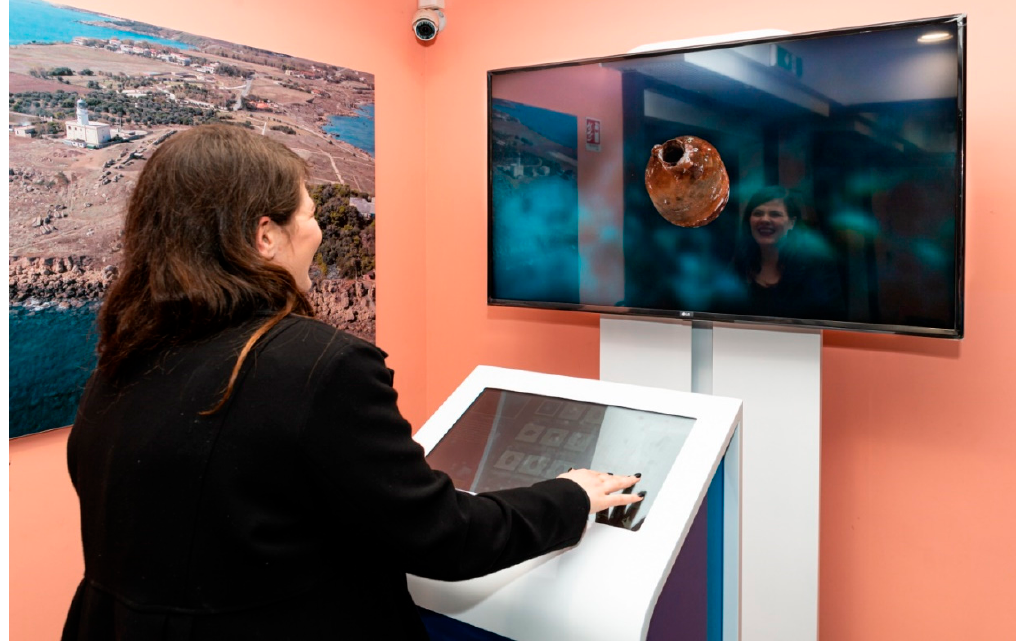
Figure 6. User interacts with a digital replica of an artefact displayed on the TV screen .